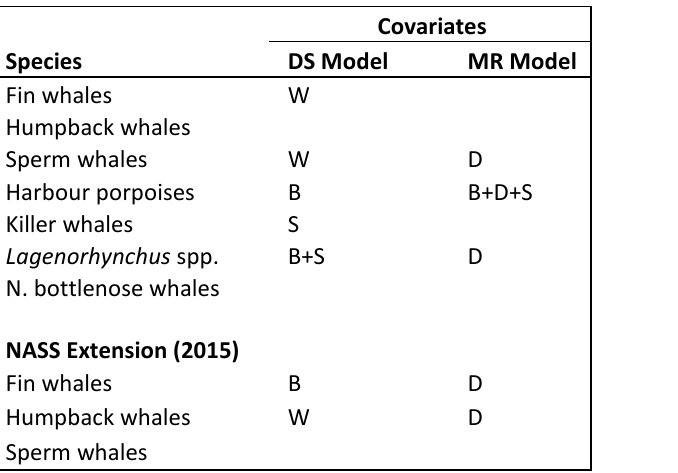
Table 3. Covariates included in the final models for each species for the distance sampling model (DS model) and the conditional detection function (mark recapture or MR model). Distance (D) is automatically added as a covariate in the DS model. B=Beaufort Sea State, W=weather, Ves=vessel, V=visibility, G=glare, S=group size, D=distance.